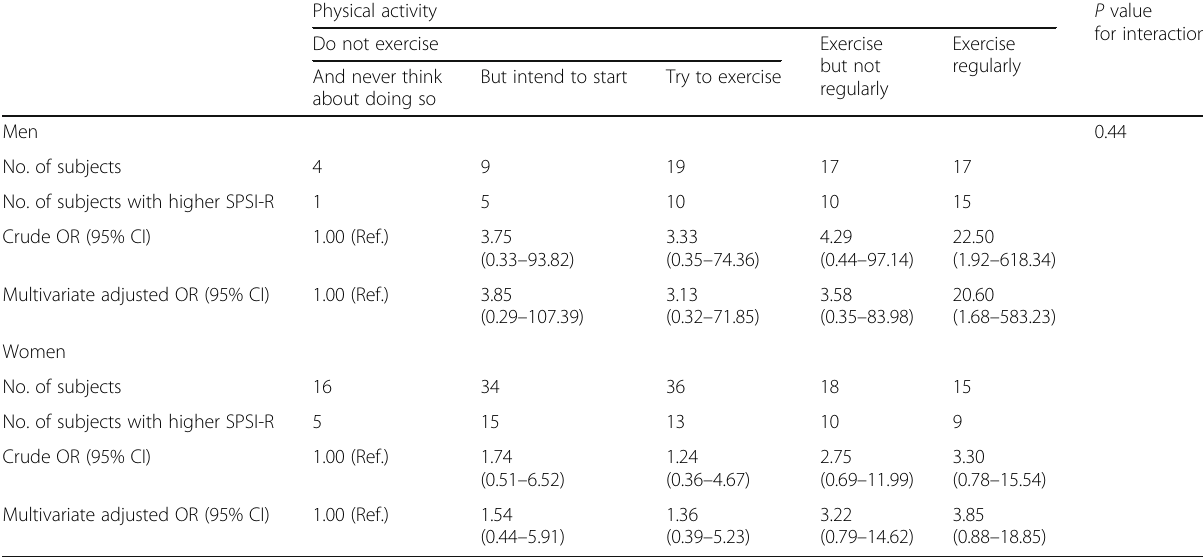
Table 4 Multivariate OR and 95% CI of higher SPSI-R according to physical activity stratified by sex Physical